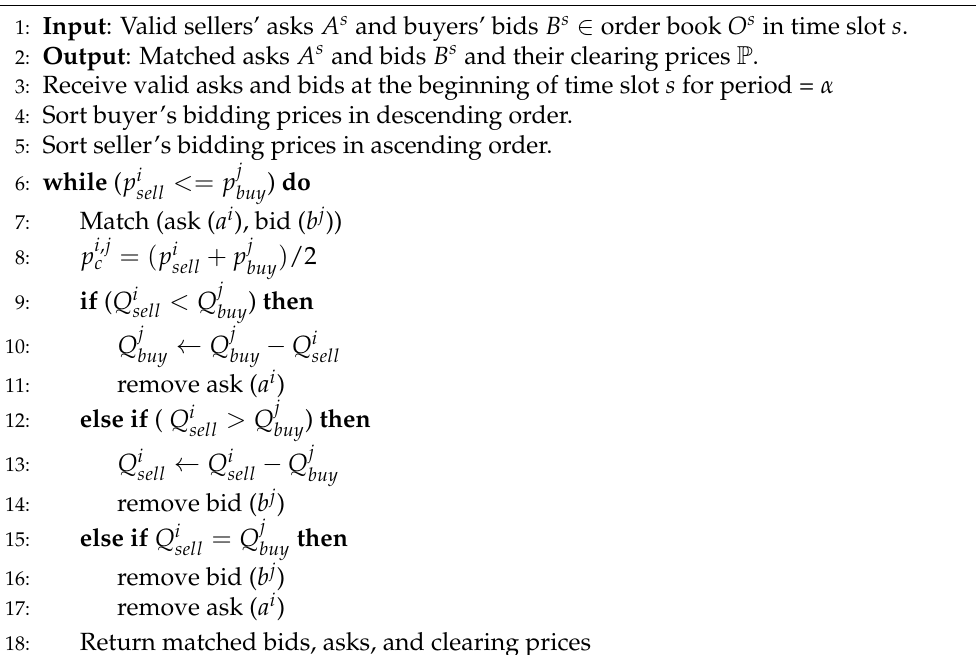
Algorithm 2 Discrete-Time Double Auction With Average